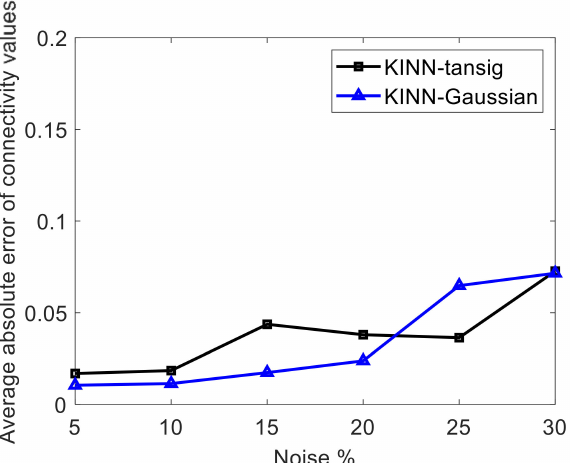
Figure 17. The average absolute error of connectivity values by KINN-tansig and KINN-Gaussian in the noise measurement case. The black line is the error curve of KINN-tansig and the blue line is the error curve of KINN-Gaussian.